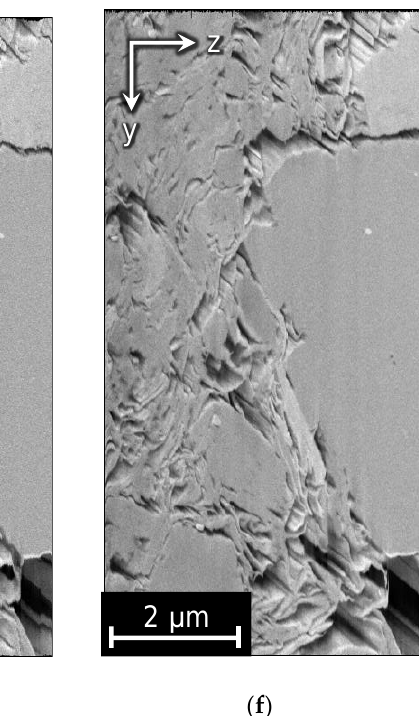
Table 3. Alignment metrics for image